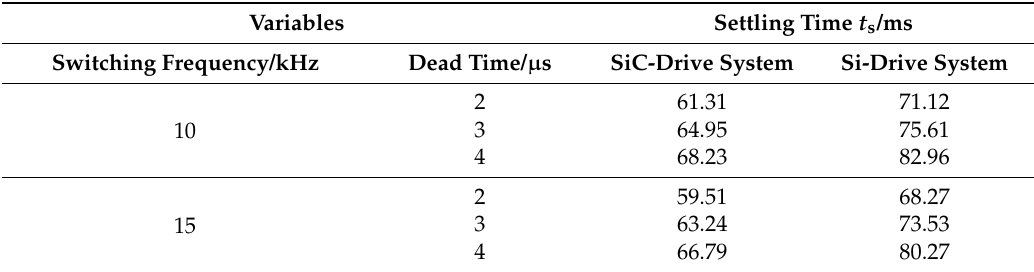
Table 4. The step response results of speed loop with different switching frequency and dead time.